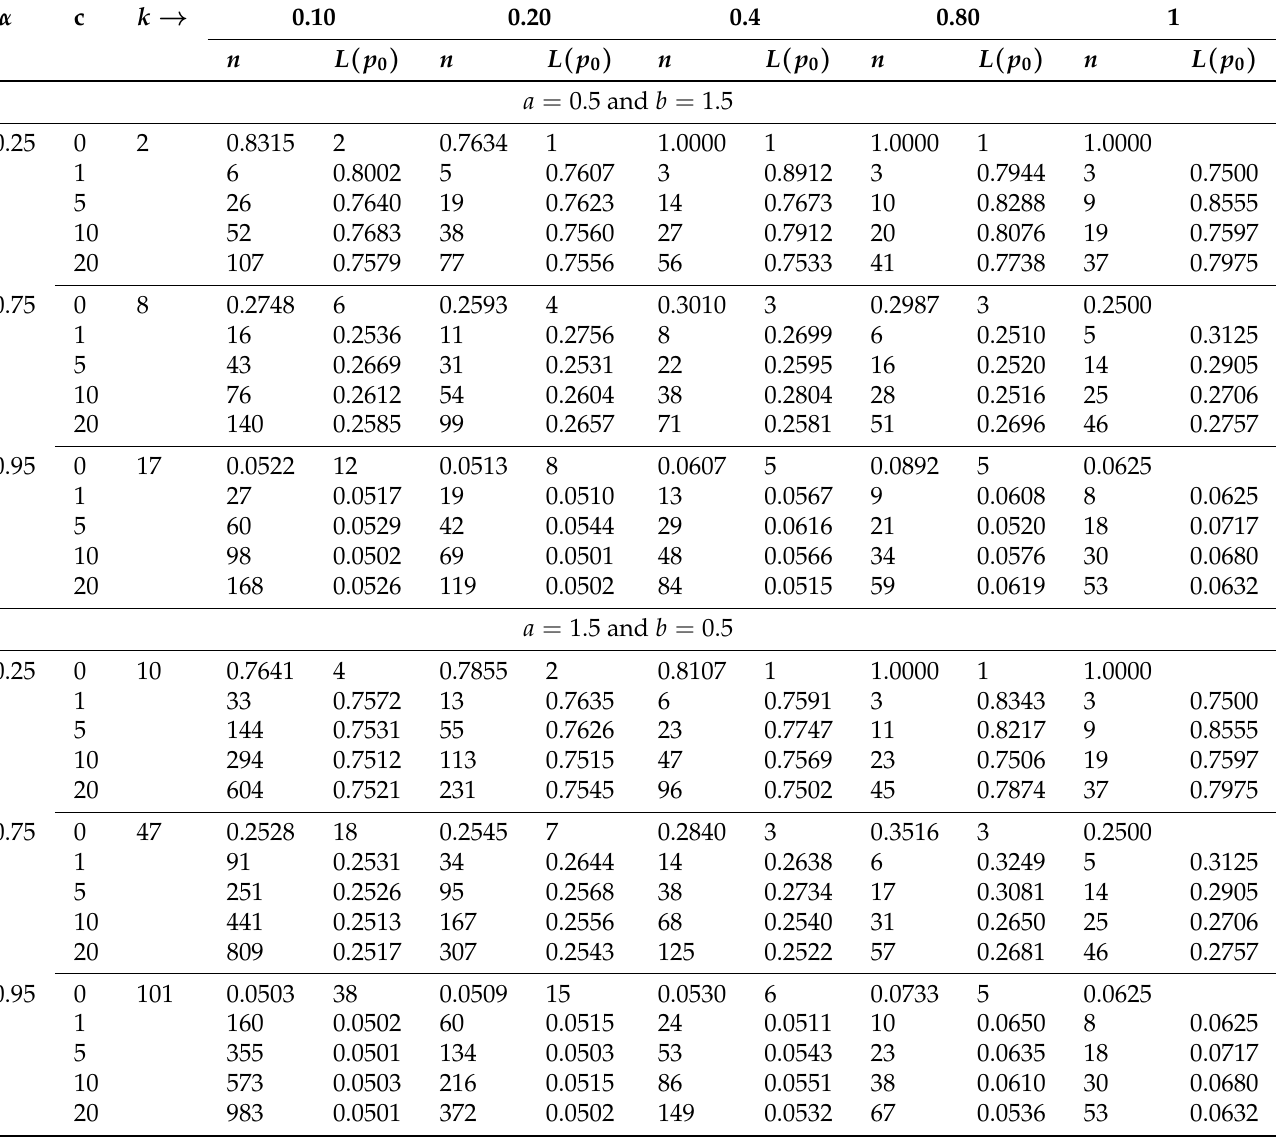
Table 3. ASPs for the BBE 2 distribution with parameters: λ = 0.5, θ = 0.25 and different values for a and b